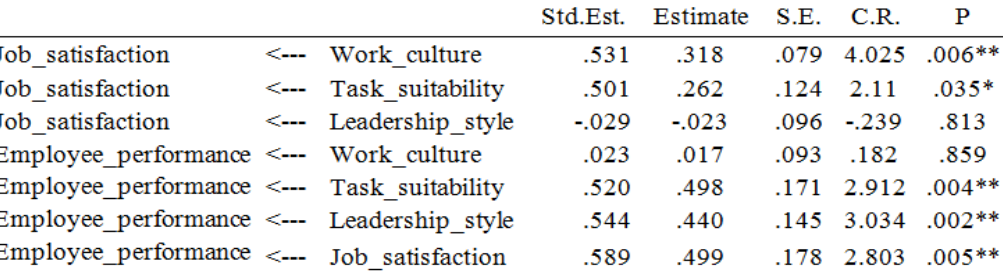
Table 1 : Results of confirmatory factor analysis